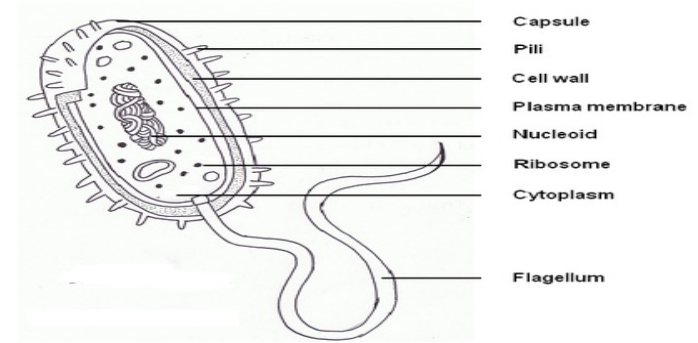
Figure 1. Structure of Escherichia coli . Reprinted from [24].